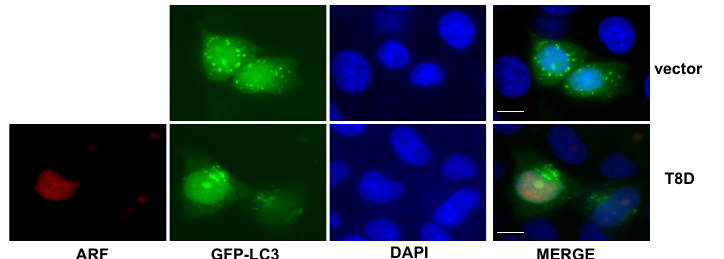
Figure 3. HeLa cells were transfected with GFP-tagged LC3 protein-expressing plasmid, with or without ARF-T8D-expressing vector. Twenty-four hours post-transfection, cells were incubated in HBSS and 50 µ M chloroquine to visualize autophagosomes formation. ARF was visualized using an anti-X-press antibody and nuclei by DAPI staining. Representative images were taken with a Zeiss confocal laser-scanning microscope, as previously described (see Section 2). Scale bar 10 μ m